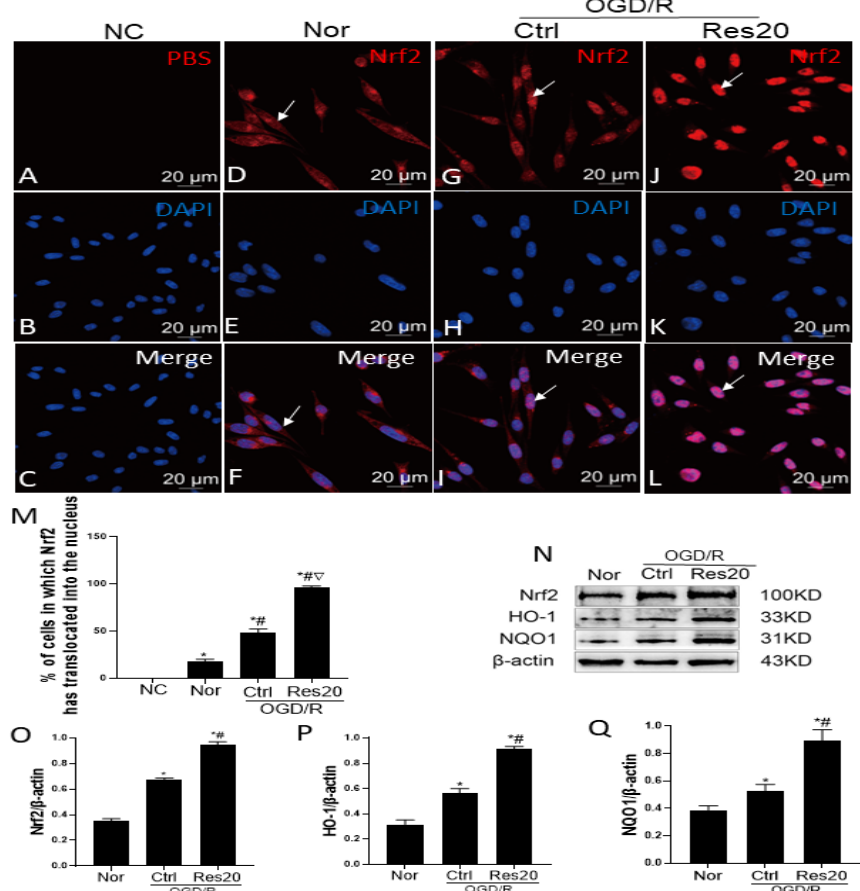
Figure 3. Resveratrol strengthens activation of the Nrf2 signaling pathway in N9 microglia follow- ing OGD/R injury in vitro . ( D,G,J ) Microglia were immunostained with antibodies to Nrf2 (red). ( B,E,H,K ) Nuclei were labeled with DAPI (blue). ( A ) The Nrf2 antibodies were replaced with PBS to serve as a negative control (NC). ( C,F,I,L ) Merges of A/B, D/E, G/H, J/K; Scale bar = 20 um. ( J ) Protein expressions of Nrf2, HO-1, and NQO1 with western blot analysis. ( L – M ) Quantification of data for Nrf2, HO-1 and NQO1 proteins. * p < 0.05, vs. NC group; # p < 0.05, vs. Nor group; ▽ p < 0.05, vs. Ctrl group. Data are presented as the mean ± standard deviation and were compared using a one-way analysis of variance ( n = 3 for each group). Nor, normal; Ctrl, control; Res20, 20 μM resveratrol.